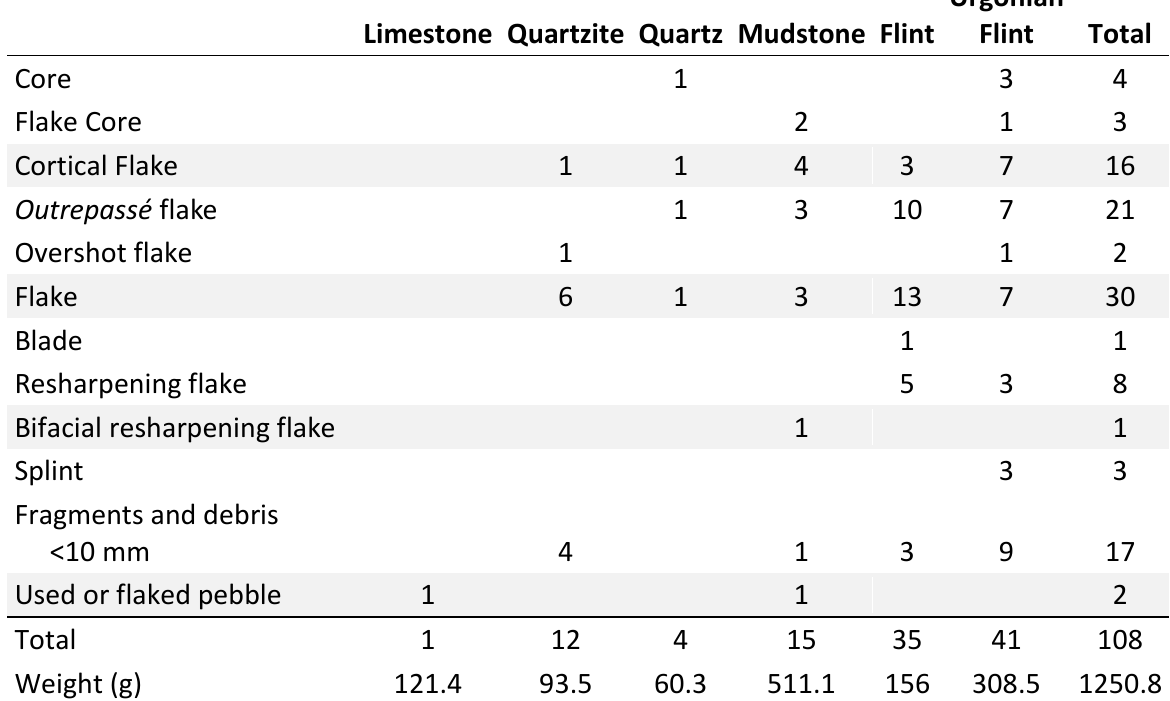
Table 1. Technological composition of Ventalaperra's level III (depth between -45 and -70 cm), Barandiarán and Aranzadi's